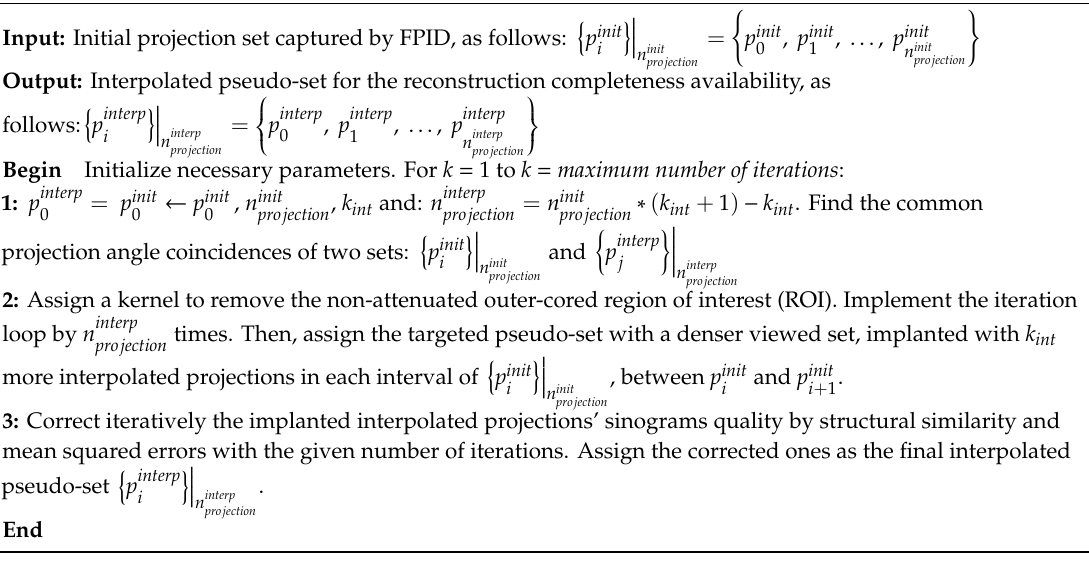
Algorithm 1: “Densification enrichment process” or Pseudo-Set Interpolation